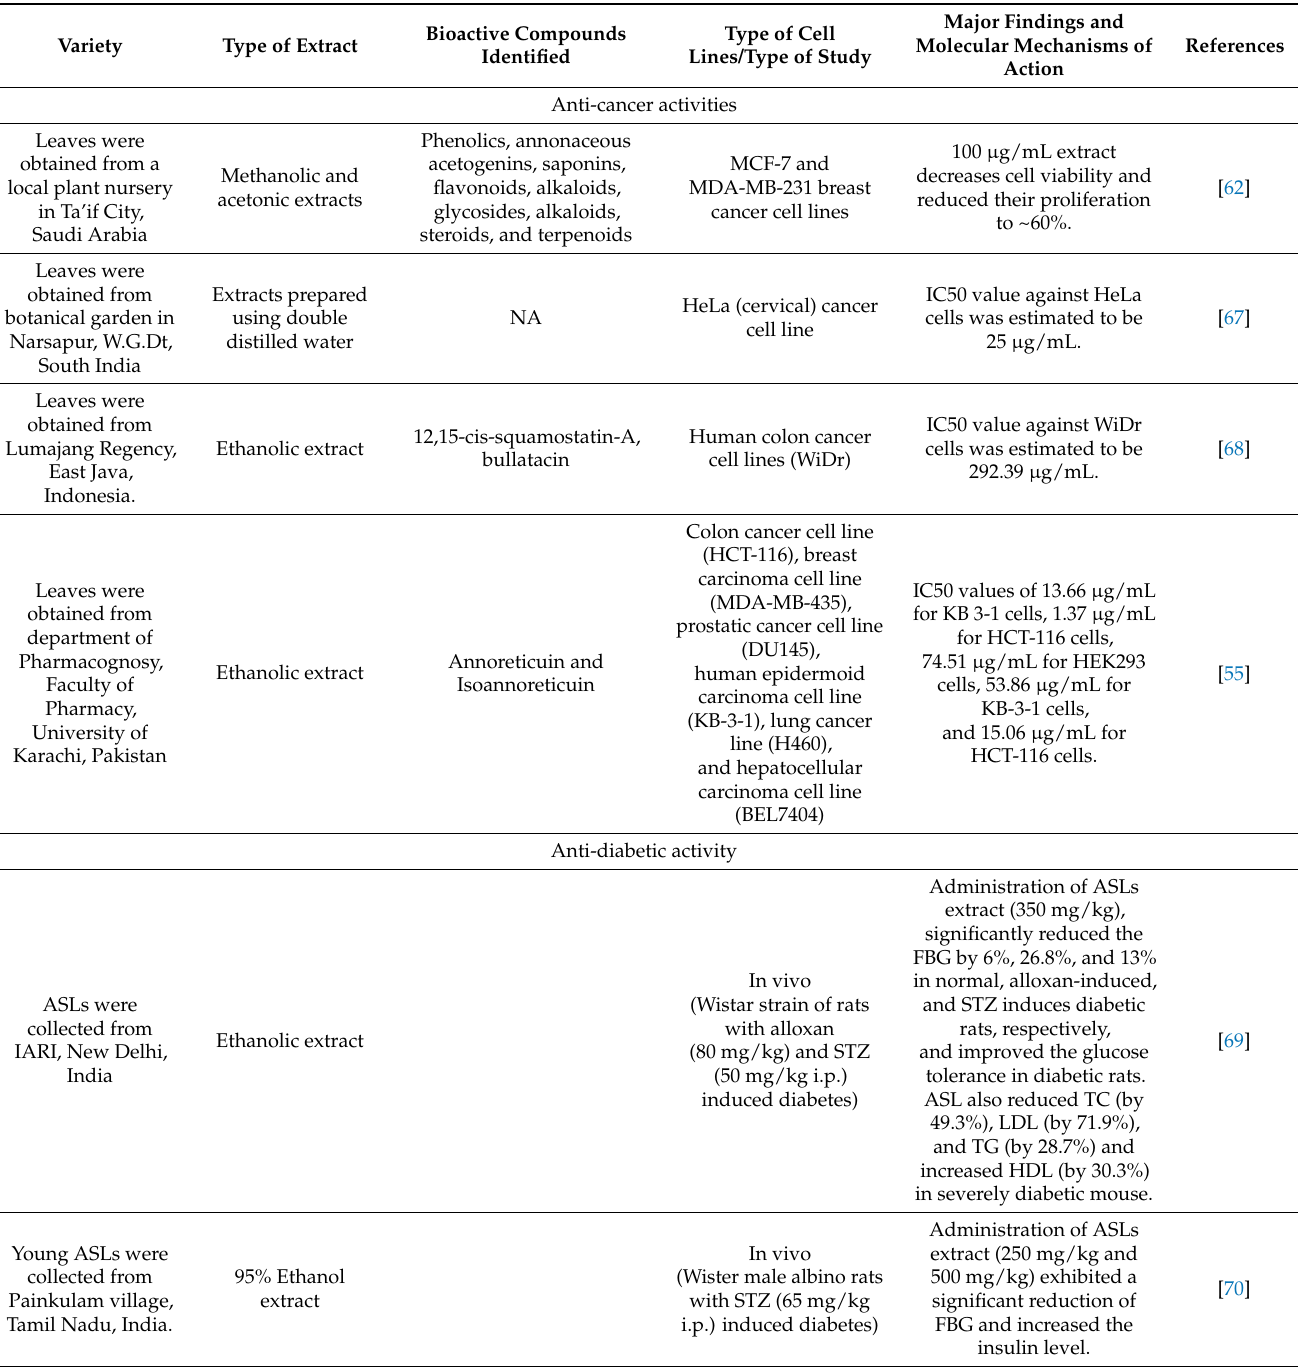
Table 4. Biological activities of Annona squamosa L. leave